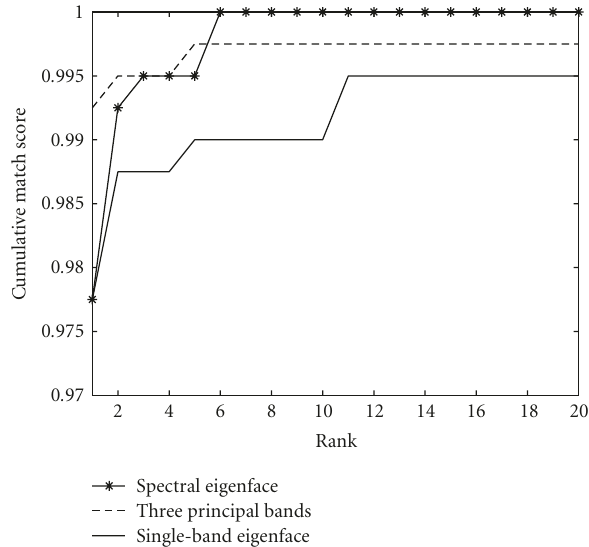
Figure 10: Comparison of spectral eigenface method with single- band and multiband